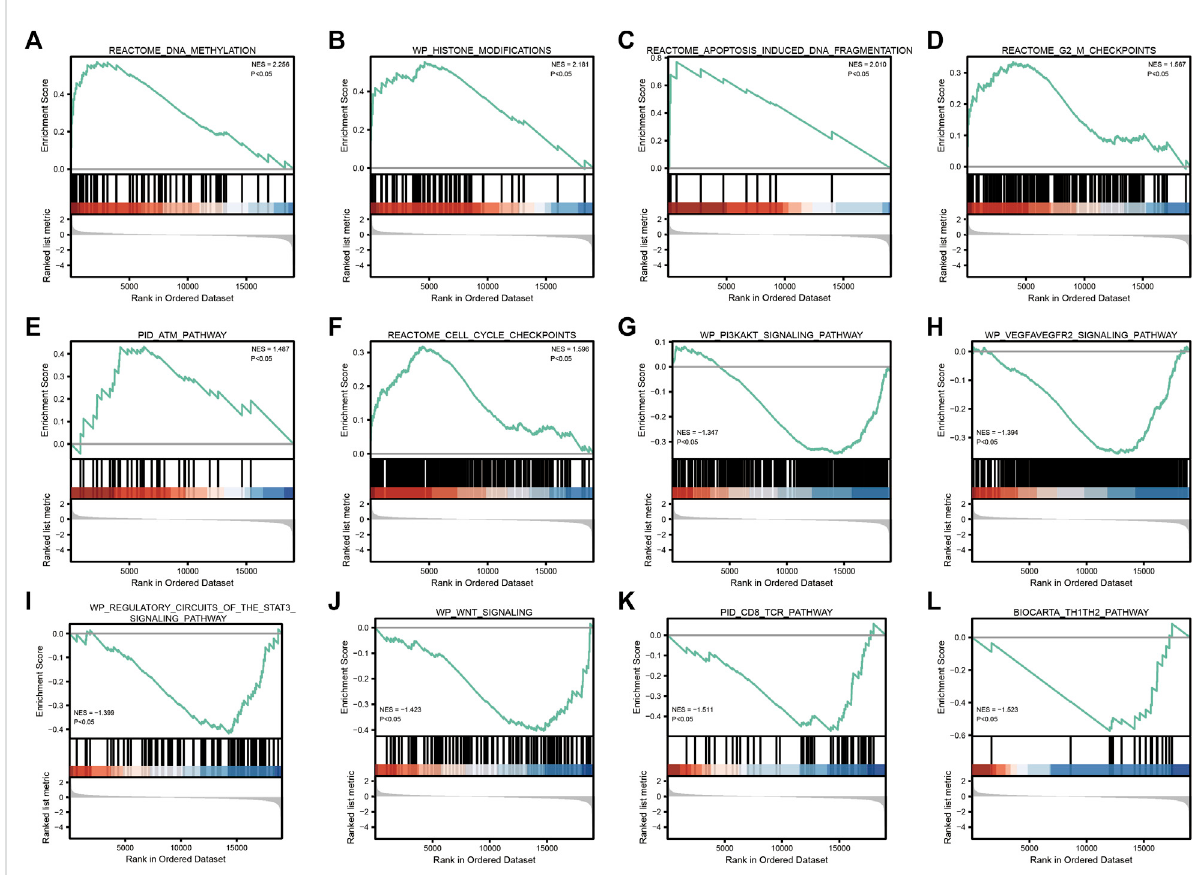
FIGURE 5 GSEA enrichment analysis. (A) ： REACTOME_DNA_METHYLATION; (B) ： WP_HISTONE_MODIFICATIONS; (C) ： REACTOME_APOPTOSIS_INDUCED_DNA_FRAGMENTATION; (D) ： REACTOME_G2_M_CHECKPOINTS; (E) ： PID_ATM_PATHWAY; (F) ： REACTOME_CELL_CYCLE_CHECKPOINTS; (G) ： WP_PI3KAKT_SIGNALING_PATHWAY; (H) ： 、 WP_VEGFAVEGFR2_SIGNALING_PATHWAY; (I) ： WP_REGULATORY_CIRCUITS_OF_THE_STAT3_SIGNALING_PATHWAY; (J) ： WP_WNT_SIGNALING; (K) ： PID_CD8_TCR_PATHWAY; (L) ： BIOCARTA_TH1TH2_PATHWAY ”